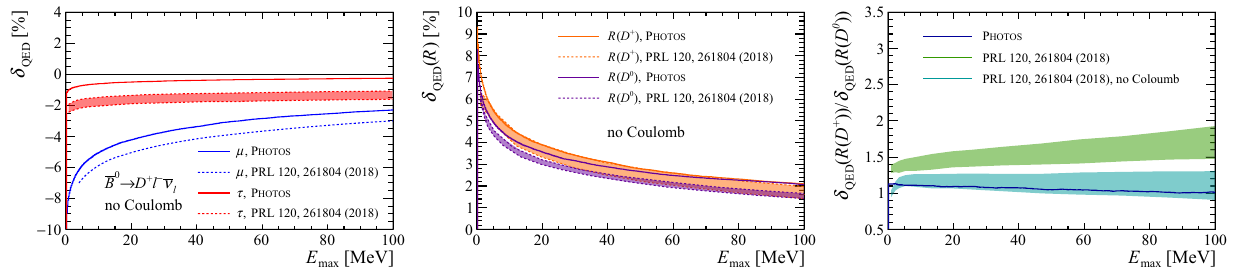
Fig. 3 Radiative corrections to the branching ratios of ¯ B 0 → D + (cid:2) − ¯ ν + ) (middle) in the case that no (cid:2) (left) and R ( D Coulomb correction is applied. The plot on the right shows the ratio δ ( R ( D + ))/δ ( R ( D 0 )) . The plots are obtained from simu- QED QED